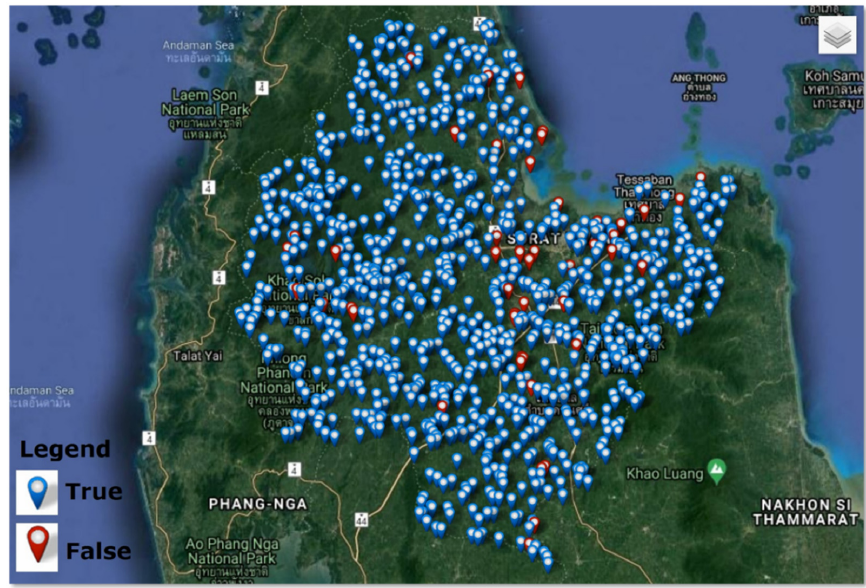
Figure 13. Evaluation of green space area classification by the proposed method compared with the ground survey; blue and red pins indicate correctly and incorrectly classified areas, respectively. Table 3. The assessment results of individual classifications by using greenness analysis and based on LULC data.